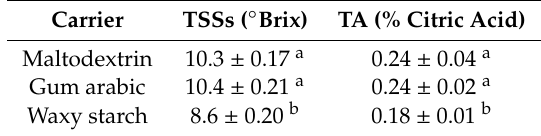
Table 3. Physicochemical attributes of freeze-dried